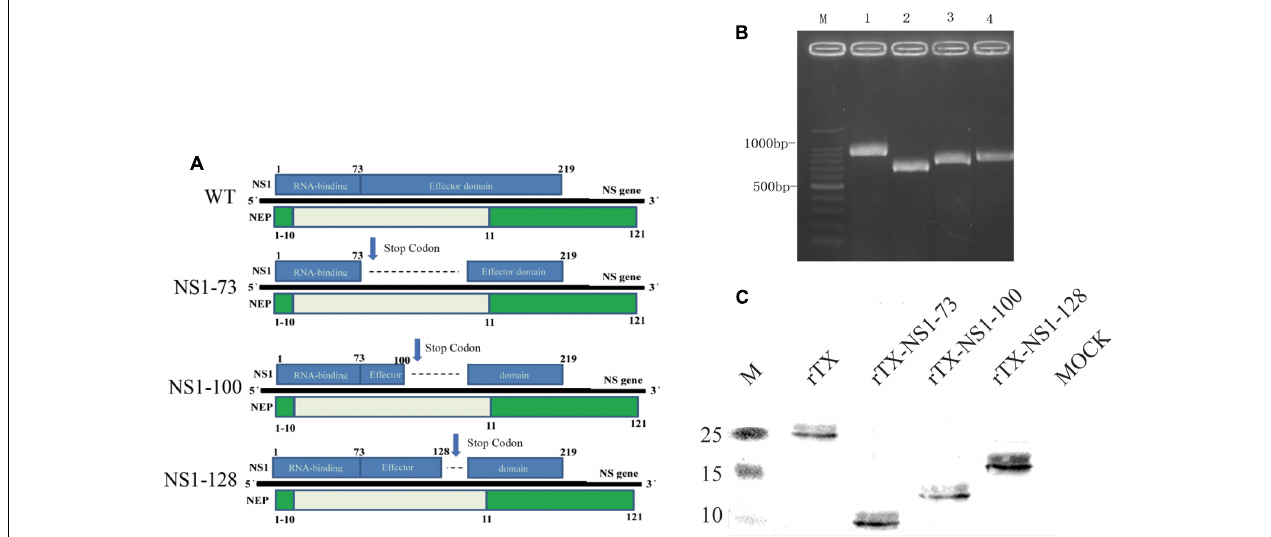
FIGURE 1 | Generation of NS1 mutant viruses. (A) Schematic of the NS segment from WT H9N2 AIV and the NS mutations. NS1 is translated from the full-length mRNA and is shown on the top of the gene; NEP is translated from spliced mRNA and is shown below the gene. Selected amino acid positions are labeled for NS1 and NEP. NS1-73, NS1-100, NS1-128 express truncated NS1 but intact NEP. (B) NS amplification of the WT and NS mutant viruses. Viral genomes were amplified using RT-PCR and the length of the NS vRNA amplicons was examined using agarose gel electrophoresis. Lane 1, 100 bp marker; Lane 2, WT; Lane 3, NS1-73; Lane 4, NS1-100; Lane 5, NS1-128. (C) Western blot analyses. Whole cell lysates obtained from MDCK cells infected with the mutant and wild-type viruses at an MOI of 1 for 3 h were subjected to SDS-PAGE and western blot analysis. Protein bands were visualized using enhanced